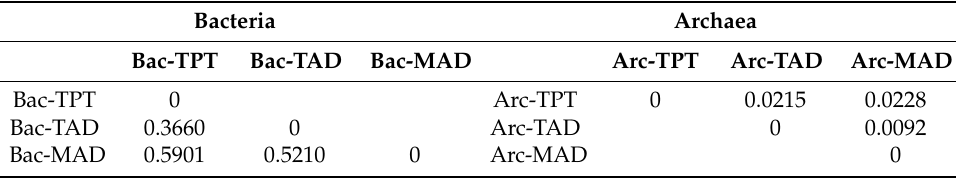
Table 3. β -diversity of microbial communities (weighted). Table 3. β-diversity of microbial communities (weighted).